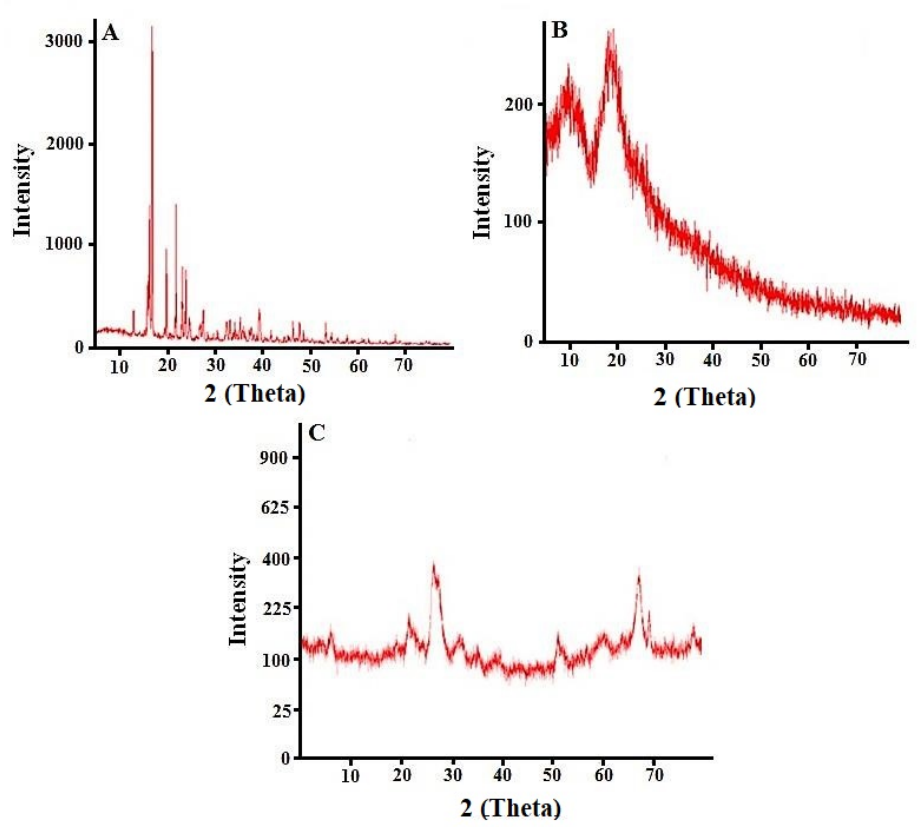
Figure 8. PXRD diffractogram of cytarabine ( A ), HP β CD ( B ) and cytarabine-loaded hydrogel network ( C ).